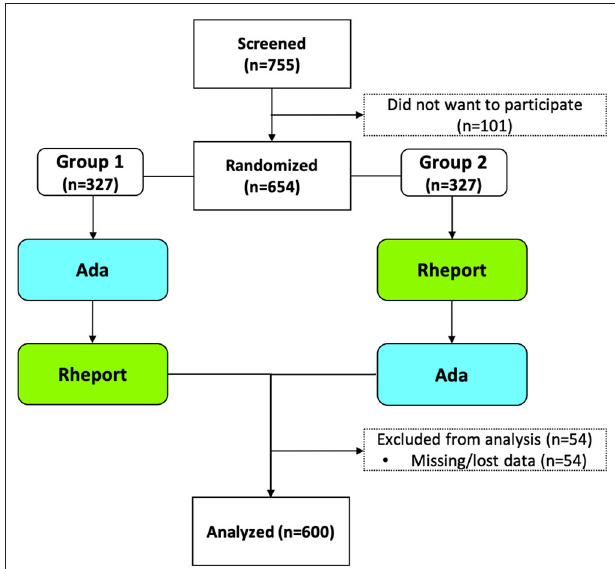
FIGURE 1 | Trial flow chart.